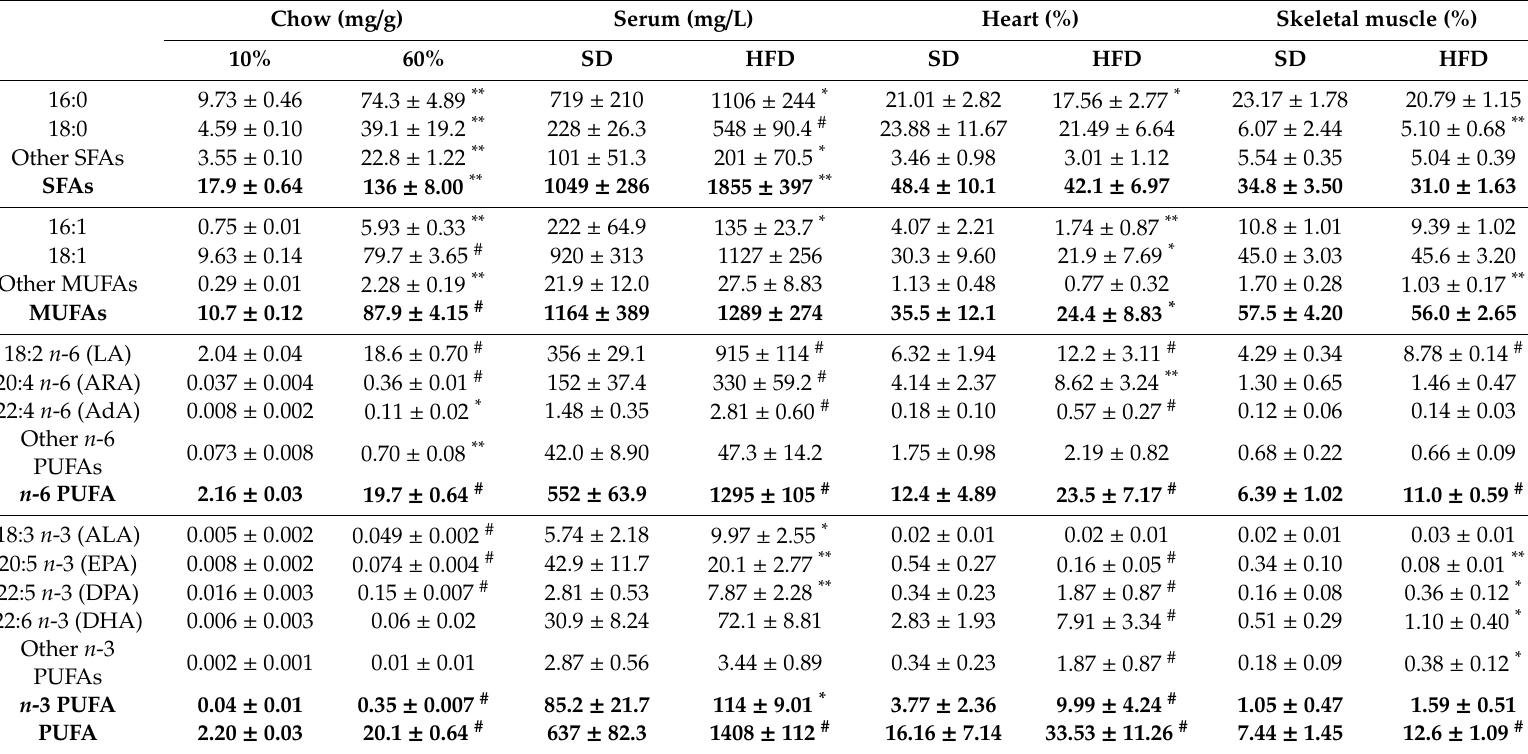
Table 2. Composition of selected fatty acids (FAs) in chow, serum and